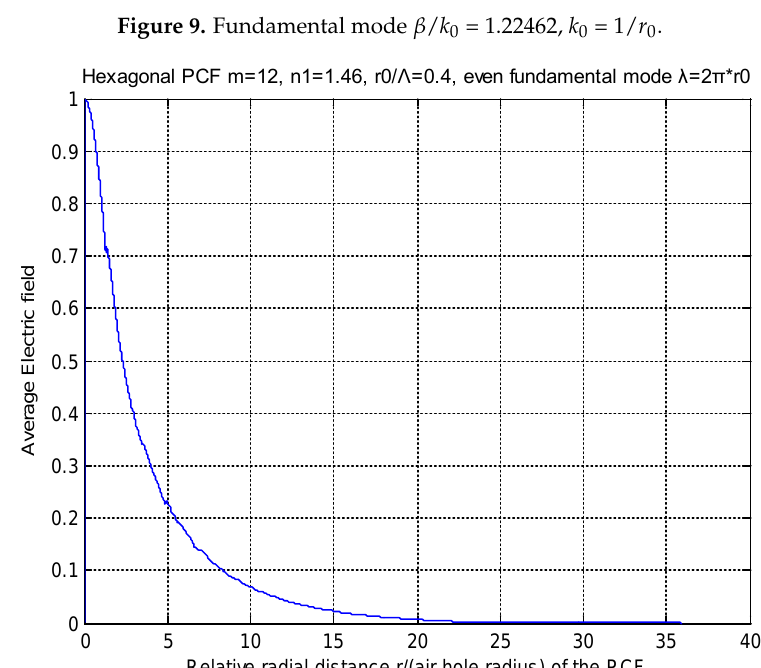
Figure 10. Average electric field of the even fundamental mode along the radial distance of the PCF.